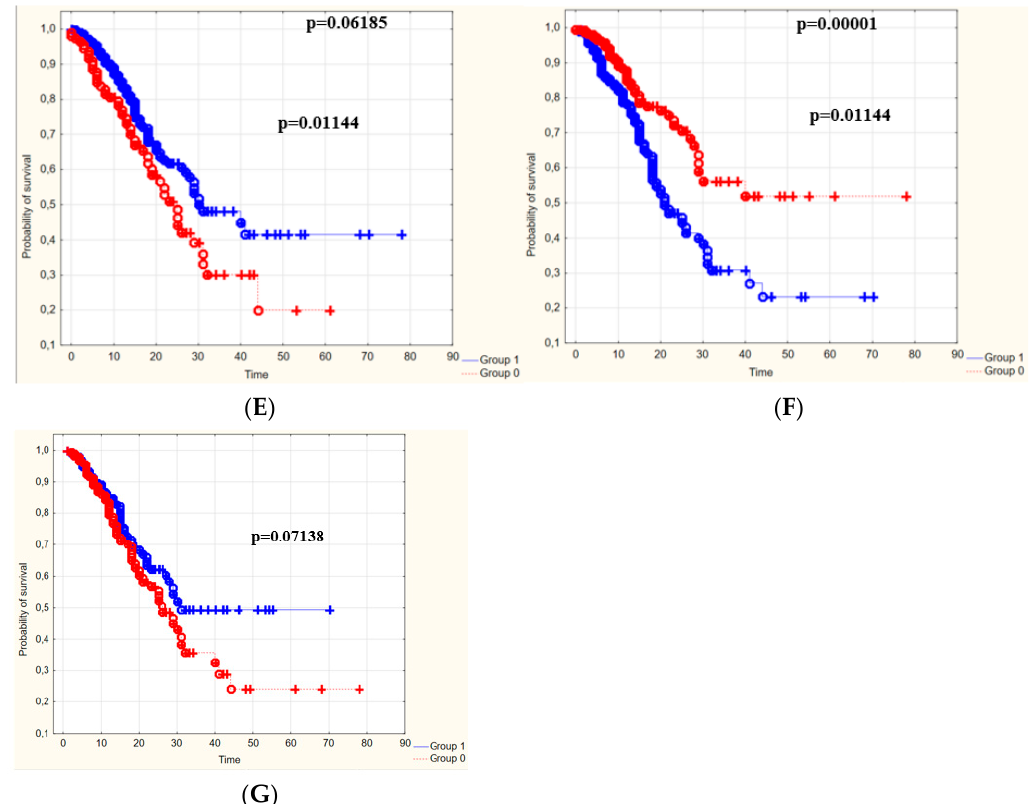
Figure 4. Kaplan–Meier survival curves for the cut-off points of individual laboratory parameters: ( A )—WBC, ( B )—PLT, ( C , D )—dimers, ( D )—CRP, ( E )—K + , ( F )—creatinine, ( G )—HGB. Group zero— values below the cut-off point, group 1—values above the cut-off point. Table 5. Comparison of survival on day 12 of hospitalization for two groups of patients against the cut-off point for individual laboratory